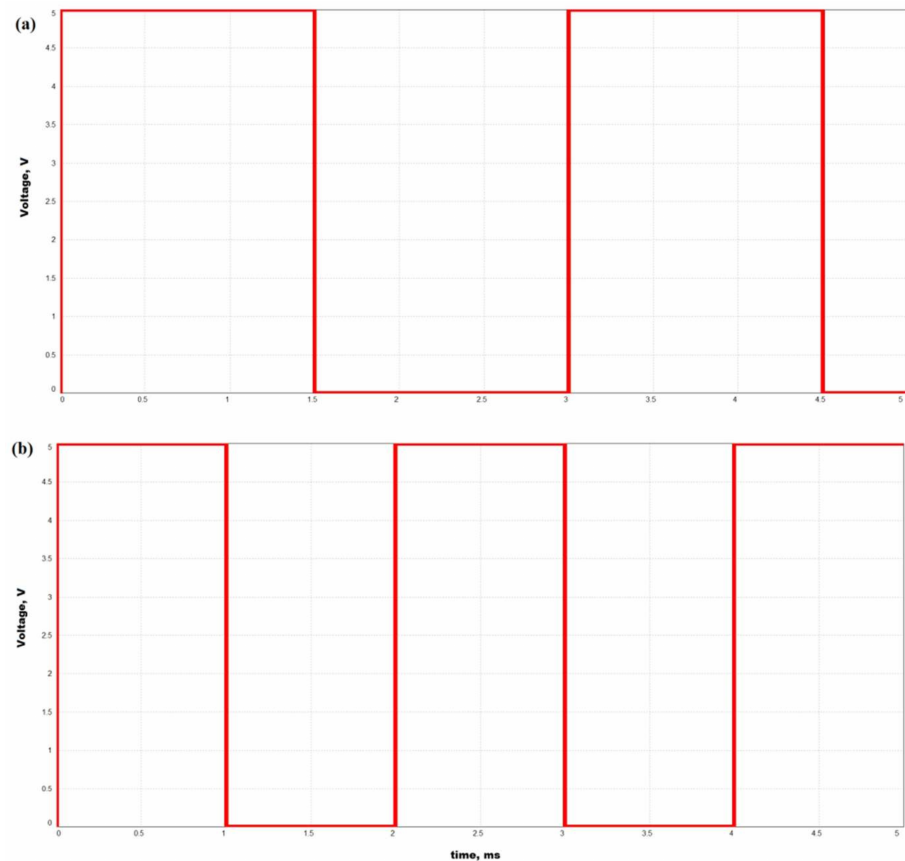
Figure 9. The sample of test impulse response of the servo of the index finger flexion ( a ) and extension ( b